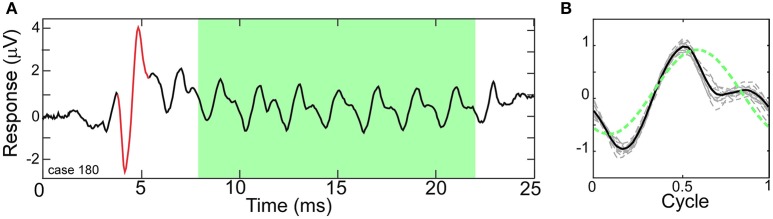
Electrocochleography (ECochG) response to a tone burst from a human CI subject. (A) A Human ECochG response to a 500 Hz tone burst presented in condensation phase. The ongoing portion is highlighted (green area). The CAP is shown in red. (B) Each cycle in the ongoing response (dashed lines) and the “average cycle” (solid line). The presence of the ANN causes distortions in the response compared to a reference sinusoid (dotted line).